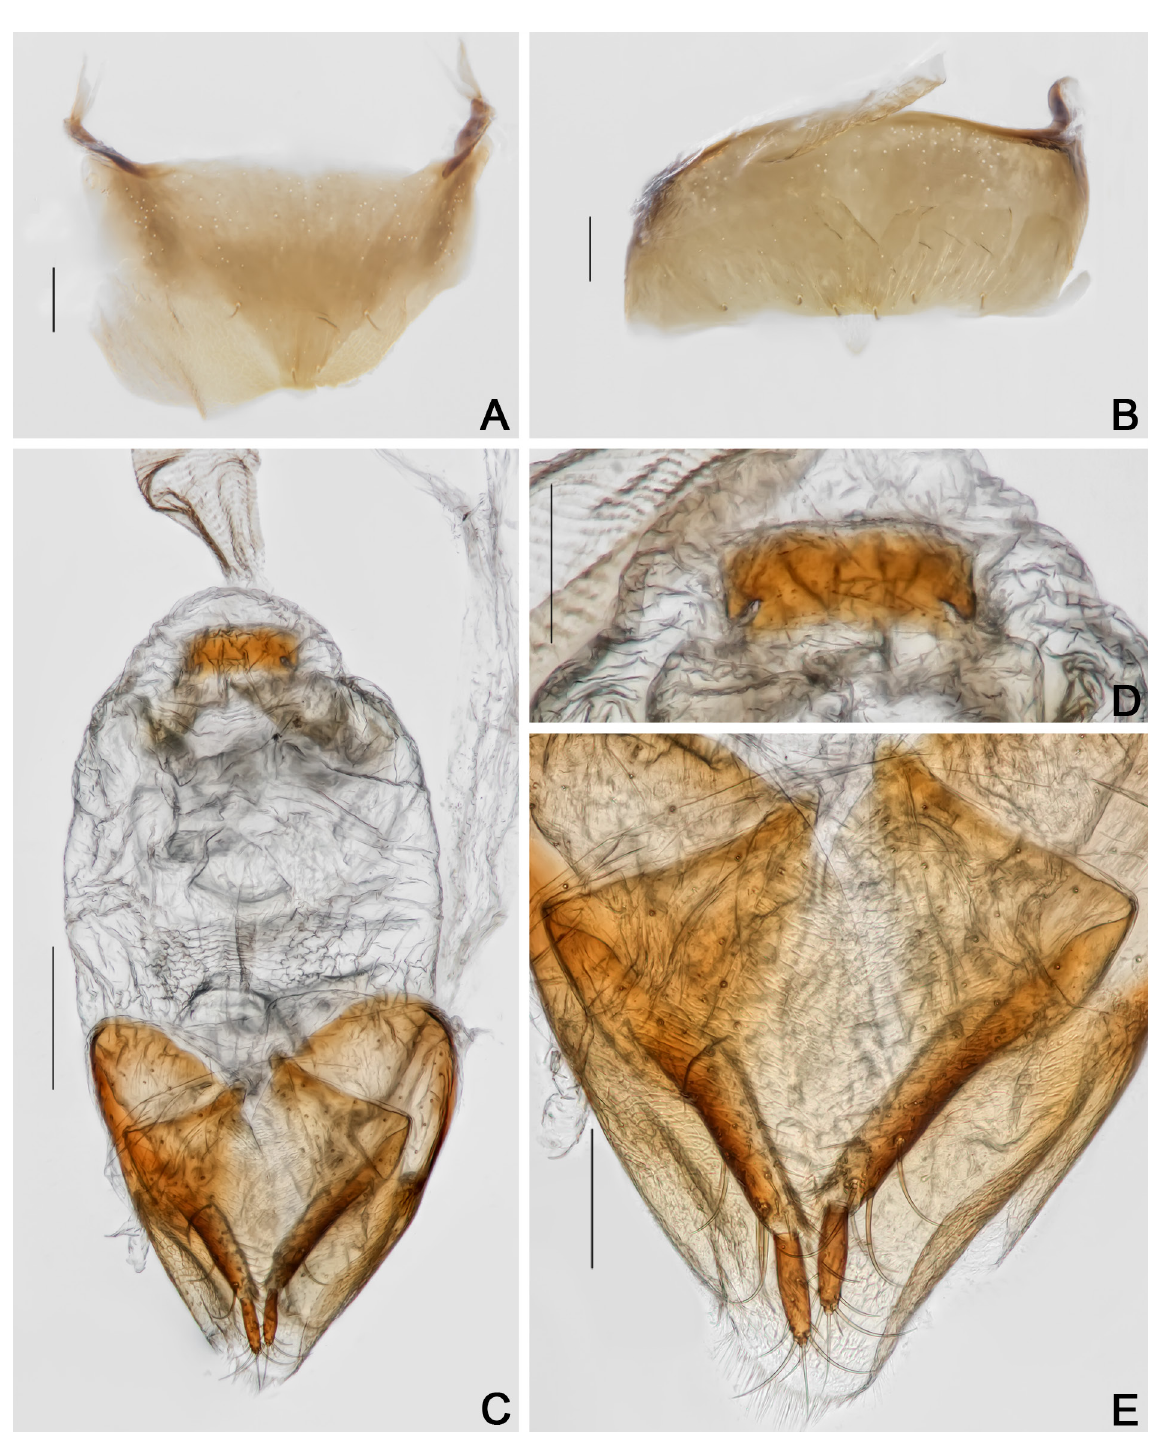
Fig. 29. Cyparium loebli sp. nov., paratype, ♀ (CELC). A . Tergite VIII. B . Sternite VIII. C . Terminalia. D . Sclerite of vaginal plate. E . Ovipositor. Specimen collected at Mata do Paraíso, Viçosa (MG, Brazil). Scale bars: A–B, D–E = 0.1 mm; C = 0.2